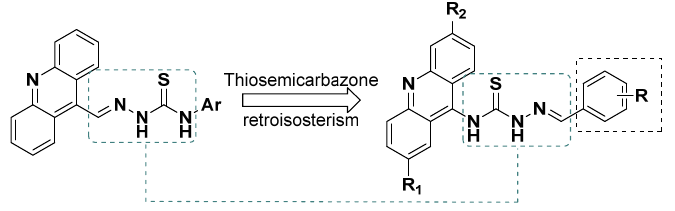
Figure 1. Structural design of new acridine–thiosemicarbazone derivatives.